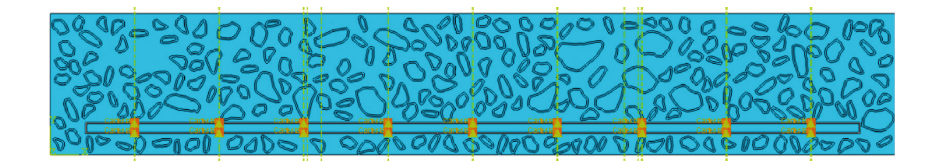
Figure 7: Tangential spring setting.